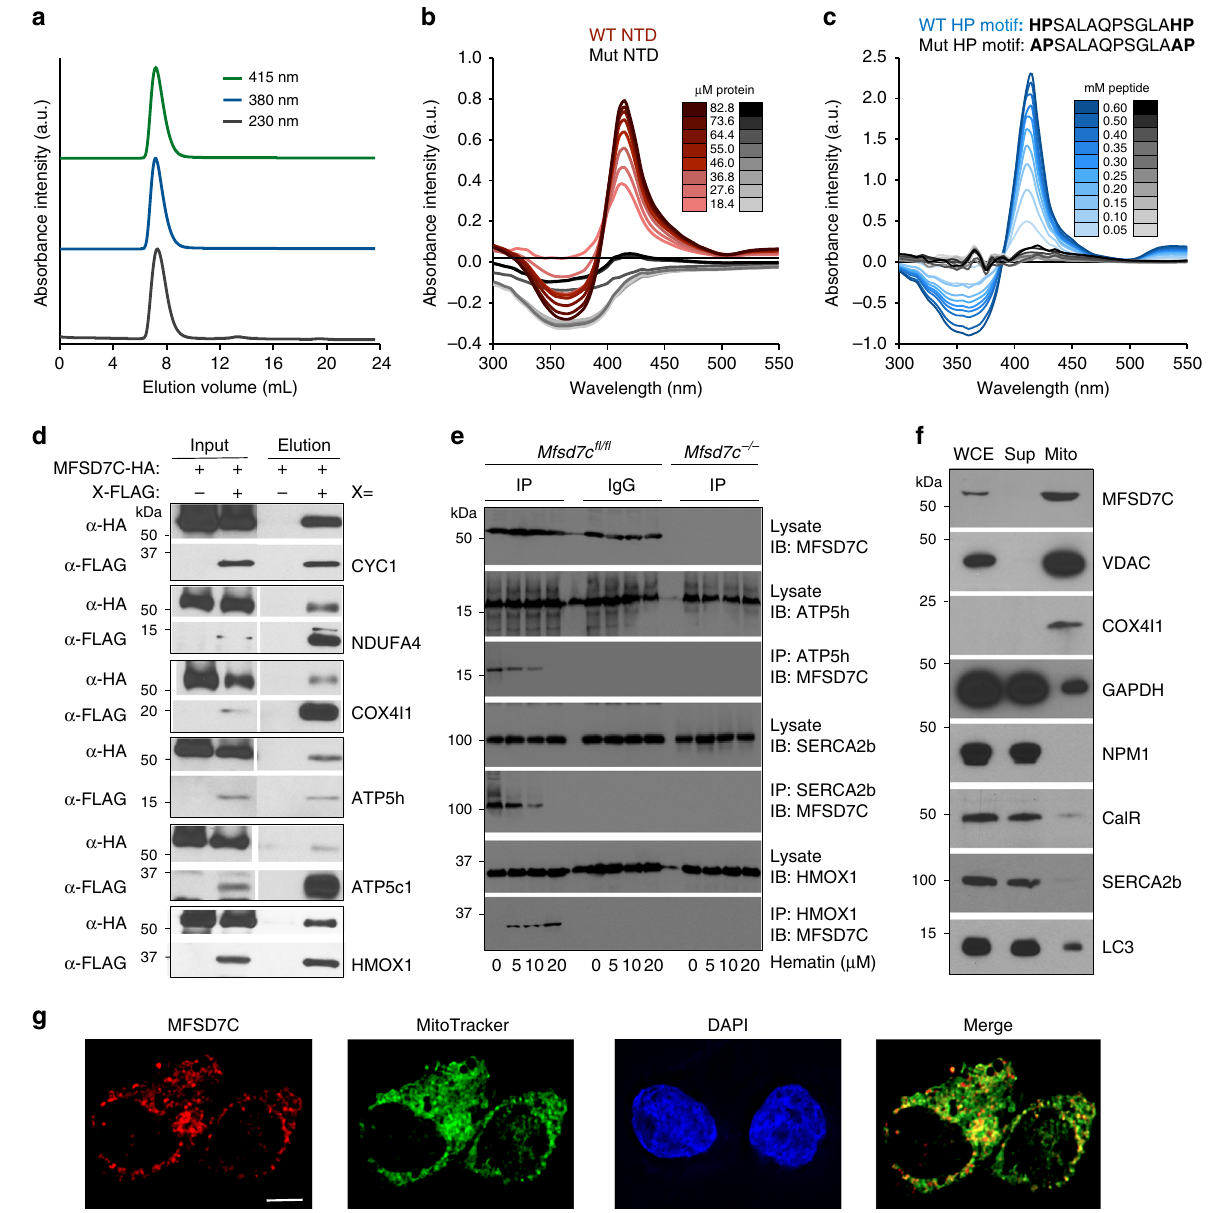
Fig. 1 MFSD7C interacts with heme and ETC components in the mitochondria. a Superdex 75 gel fi ltration chromatograms of human NTD and heme. NTD was incubated with heme and run on Superdex 75 gel fi ltration column. The fl ow through was measured for absorbance at 230 nm (gray), 380 nm (blue), and 415 nm (green). Absorbance intensity was normalized to maximum value. b Changes in absorption spectrum intensity of heme incubated with different concentrations of wild-type (red) or mutant (gray) NTD (see color scale). Heme (100 µ M) absorption was set to zero. c Changes in absorption spectrum intensity of heme (100 µ M) incubated with different concentrations of wildtype (blue) or mutant (gray) HP motif peptide (see color scale). Wildtype (WT) and mutant (Mut) peptide sequences are shown. d Co-IP and immunoblotting analysis of HA-tagged MFSD7C and FLAG-tagged CYC1, NDUFA4, COX4I1, ATP5h, ATP5c1, or HMOX1. Shown are representative data from fi ve separate experiments. e Co-IP and immunoblotting analysis of endogenous MFSD7C with ATP5h, SERCA2b and HMOX1 in bone marrow-derived macrophages from Mfsd7c fl / fl or Mfsd7c − / − C57BL/6 mice (see “ Methods ” section for details). Shown are immunoblots of MFSD7C, ATP5h, SERCA2b, and HMOX1 on whole lysates or immunoblots of MFSD7C on anti-ATP5h, anti-SERCA2b and anti-HMOX1 immunoprecipitates. Representative data from one from three experiments are shown. f Mouse whole brain extract was fractionated using differential centrifugation to enrich for mitochondria and analyzed by immunoblotting against the indicated proteins. Shown are representative data from three separate experiments. WCE: whole cell extract, Sup: supernatant, Mito: 10,000× g mitochondrial fraction. g Immuno fl uorescent localization of MFSD7C in mitochondria. THP-1 cells were stained with MitoTracker (green), fi xed and permeabilized, and then stained with rabbit polyclonal antibody speci fi c for the C-terminus of MFSD7C, followed with Alexa Fluor ® 594- labeled goat anti-rabbit antibody (red). Nuclei were labeled using DAPI (blue). Co-localization between MFSD7C and MitoTracker appears as yellow in the merged images. Scale bar in d and f : 10 µ